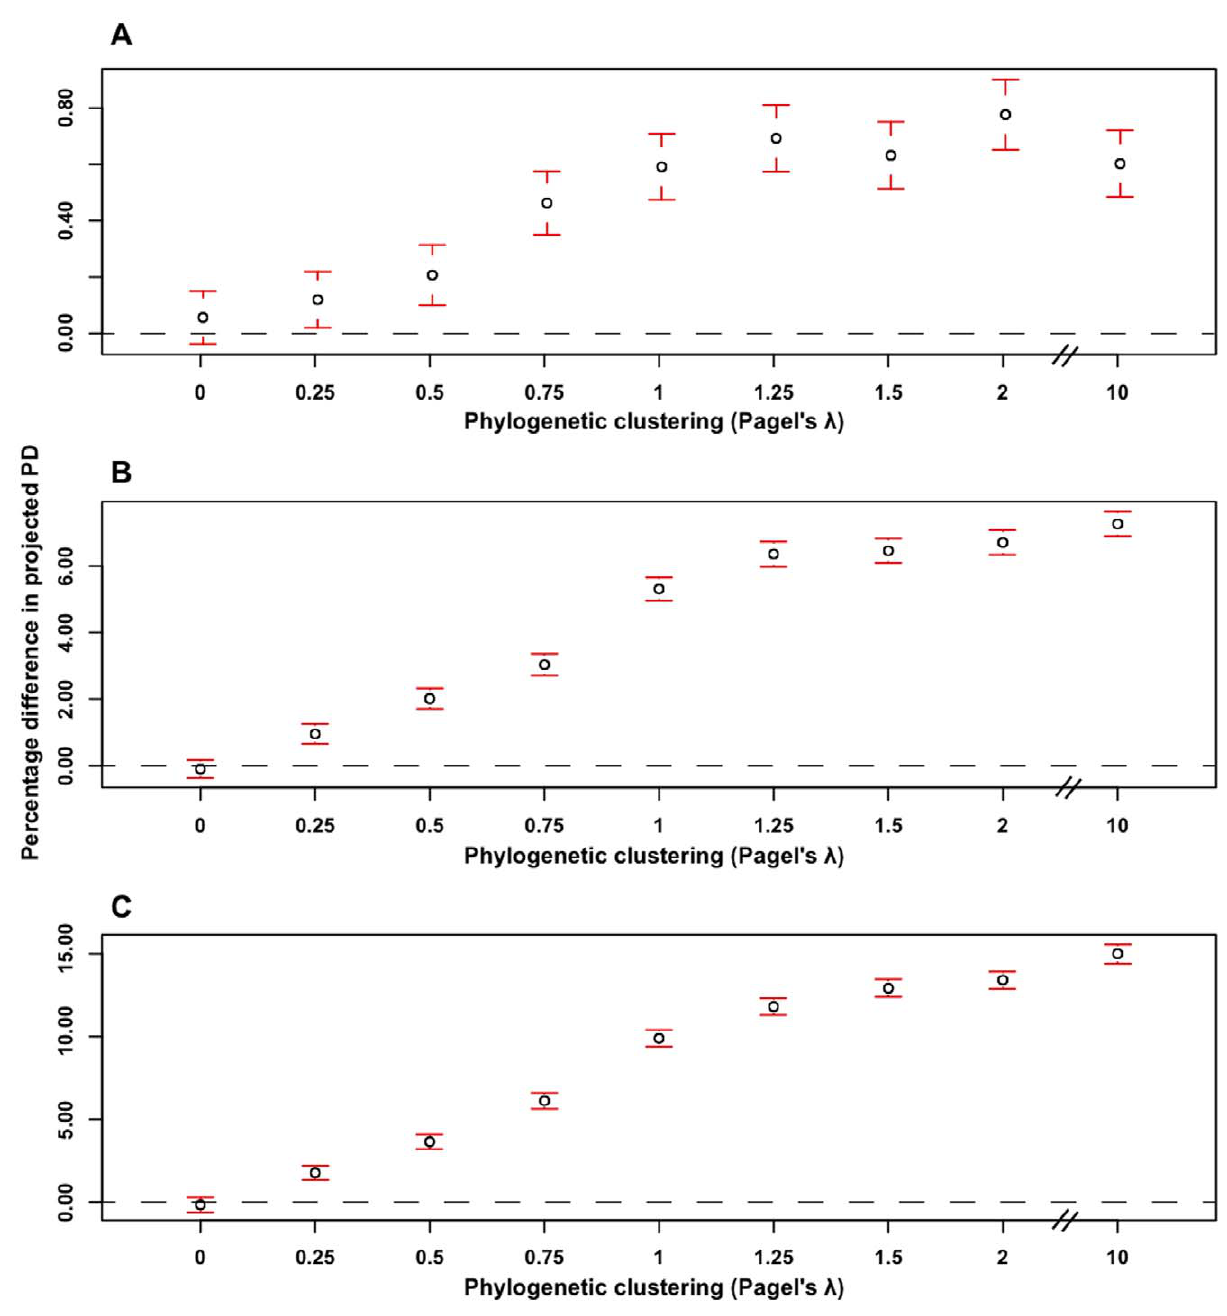
Figure 3. Percentage difference in projected PD with phylogenetic clustering in 64-tip Yule trees. A) mean p(ext) =0.25, B) mean p(ext) =0.5, and C) mean p(ext) =0.75. Data points in percentage denote the amount of additional loss of projected PD (relative to random extinction) with increasing phylogenetic clustering. Dashed line indicates that loss under random extinction. Error bars around points represent the 95% confidence interval with a sample size of 1000 trees. Note differences in vertical axes.